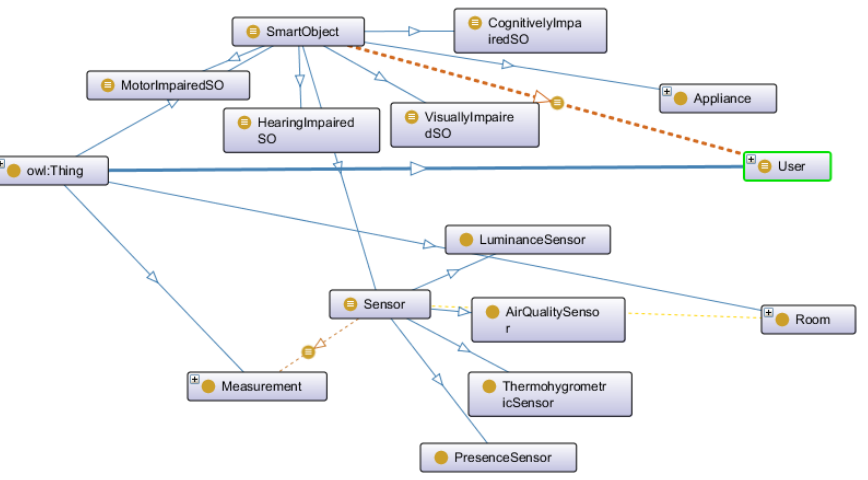
Figure 4. An excerpt of the main concepts of the ontology developed for Case 1 captured with Protégé ontology editor.